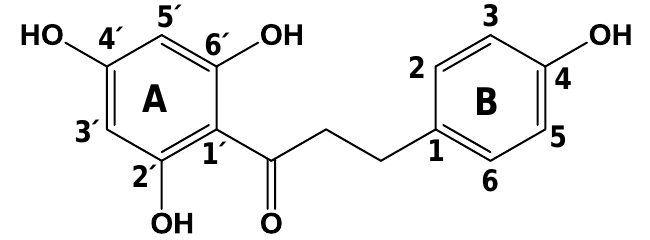
Figure 1. Chemical structure of phloretin.